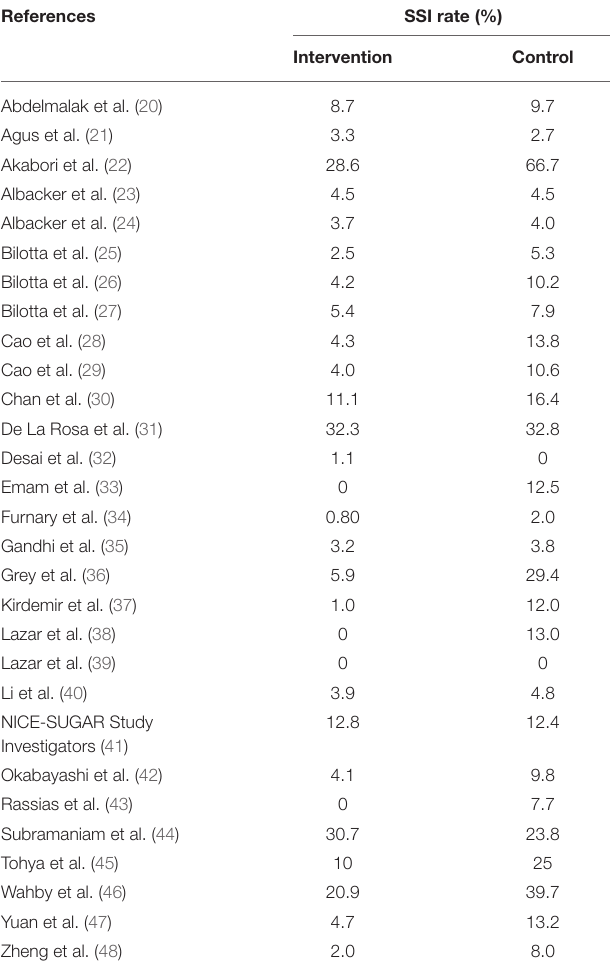
TABLE 3 | Surgical site infection (SSI) rates in included